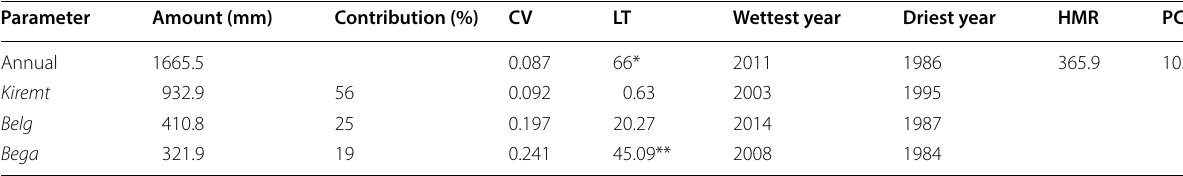
Table 1 Trends of annual and seasonal rainfall in Alwero watershed